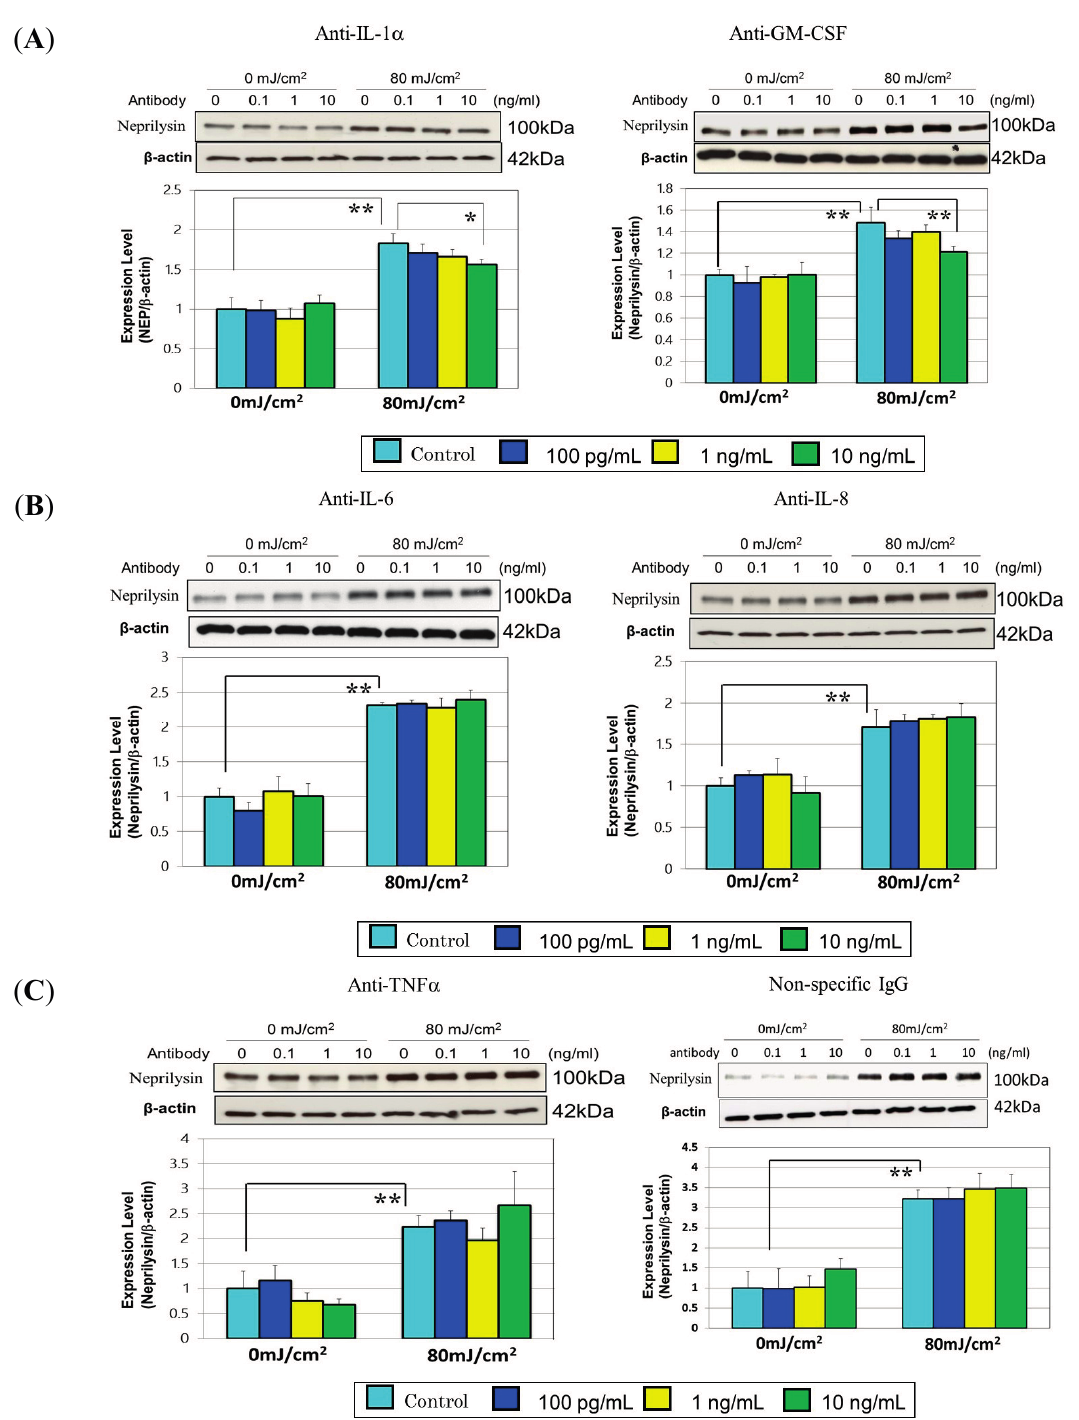
Figure 7. A neutralizing antibody abrogates the stimulated neprilysin (NEP) protein. ( A ) anti-human IL-1 α antibody ( left ): anti-human GM-CSF antibody ( right ); ( B ) anti-human IL-6 antibody ( left ): anti-human IL-8 antibody ( right ); ( C ) anti-human TNF α antibody ( left ): non-specific mouse IgG ( right ). Antibodies as well as non-specific IgG were added at the indicated concentrations to the two-fold diluted conditioned medium. After replacement with the prepared conditioned medium, human fibroblasts were maintained in culture for 72 h. Lysates of human fibroblasts were then subjected to Western blotting analysis. Values are means ± S.D. derived from three independent experiments. ** p < 0.01, * p <